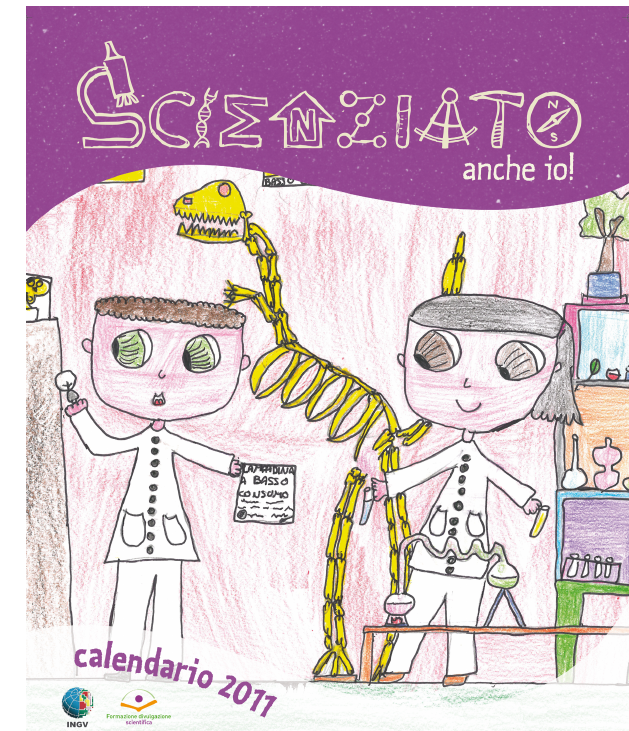
Figure 4. The design chosen for the 2011 calendar cover sum- marizes the main themes presented in the drawings sent by the children. Smiling scientists, confident of the potential of science, engaged in enthusiastic discoveries to improve life on the planet (edited by INGV Laboratorio Didattica e Divulgazione Scientifica and INGV Laboratorio Grafica e